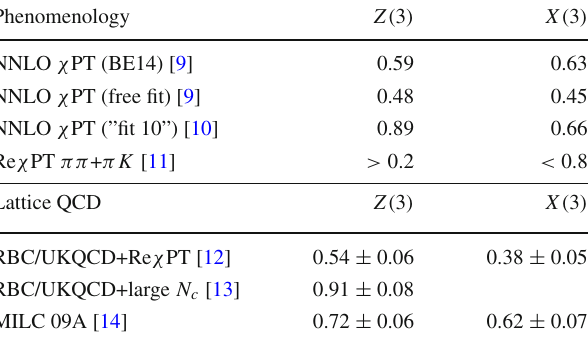
Table 2 Chosen results for the three flavor order parameters